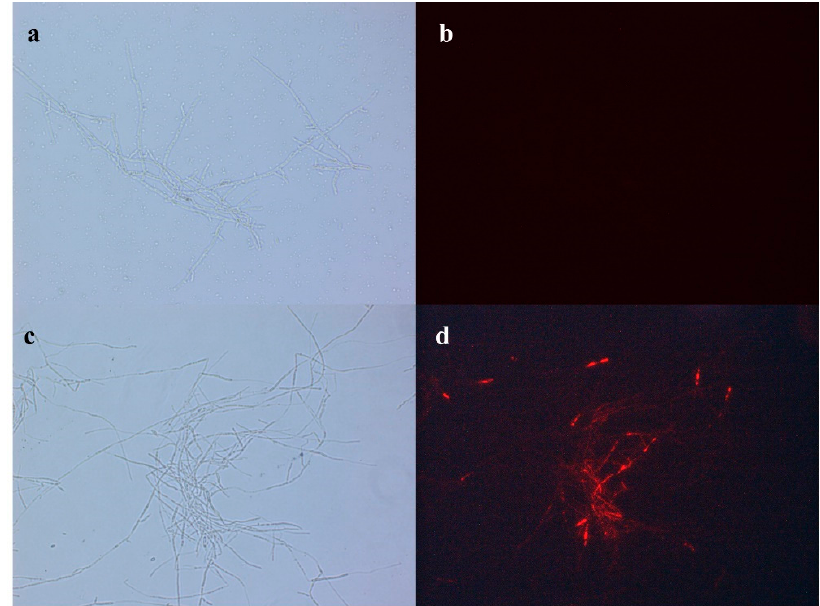
Figure 6. Effects of iturin A on membrane permeability of mycelia. Optical microscope, ( a , c ); Fluorescence microscope, ( b , d ); Control, a and b; Treatment, c and d, being treated with iturin A at a concentration of 60 μ g/mL.